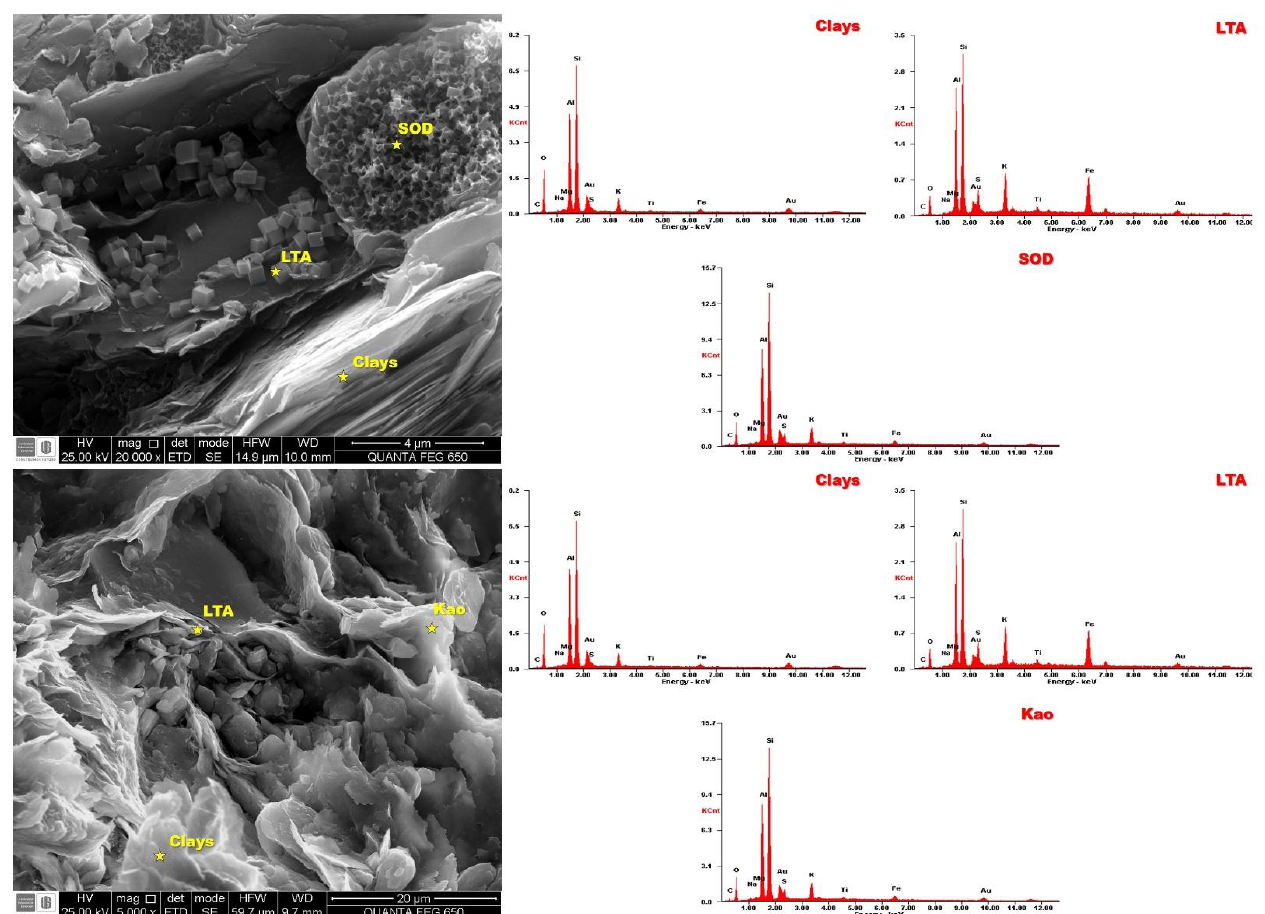
Figure 6 . SE images of the analyzed aggregates of Na-A zeolite, sodalite, and clays. LTA: Na-A zeolite; SOD: Sodalite; Kao: Figure 6. SE images of the analyzed aggregates of Na–A zeolite, sodalite, and clays. LTA: Na–A zeolite; SOD: Sodalite; Kao: Kaolinite. Kaolinite.